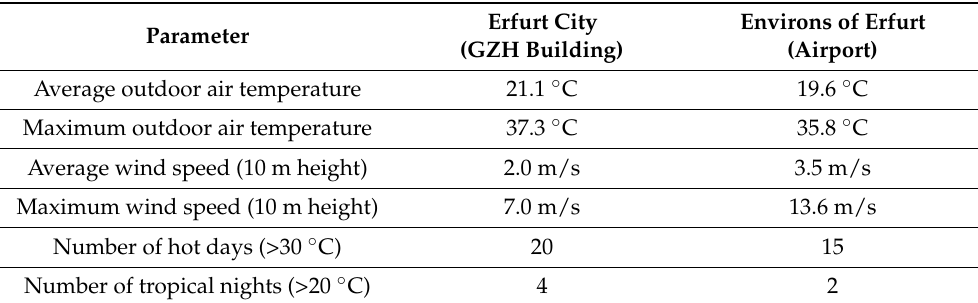
Figure 2. ( a ) Outdoor air temperature (2 m height), ( b ) wind speed (10 m height) and ( c ) solar irradiation profile of the meteorological dataset generated for building performance simulation, representing the summer 2019 for the location of the GZH building in Erfurt city (solar irradiation from Jena). As comparison, wind and air temperature profiles for the DWD meteorological station Erfurt-Bindersleben (airport) are shown, representing the environs of the city [26–28]. Table 2. Characteristic meteorological values of summer 2019 (1 June to 30 September) of the generated meteorological data input for the location of the GZH building and comparison to the DWD meteorological station Erfurt-Bindersleben (airport), representing the environs of the city (cf. Figure 2).